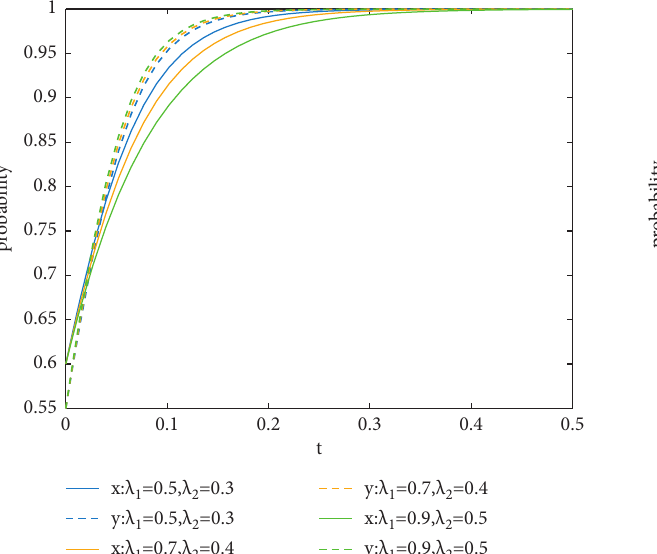
Figure 8: The effect of knowledge stock on knowledge hiding.